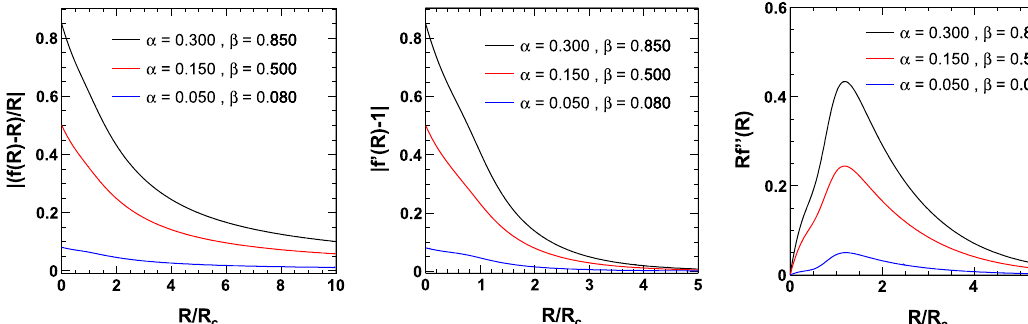
Fig. 7 Plots of solar system test functions with respect to R 0 / R c Table 1 Numerical values of solar system test functions for specific values of R 0 / R c ,α and β